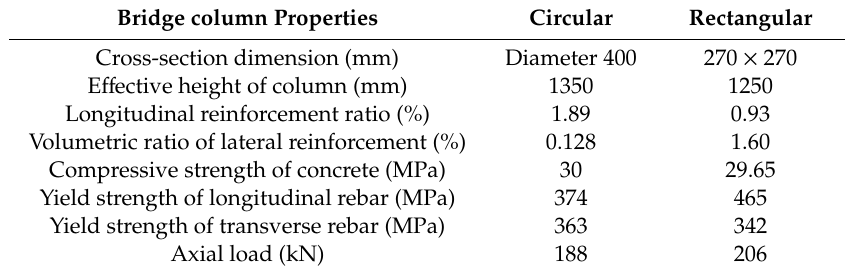
Table 2. Material properties and dimensions of the two columns adopted in this study.